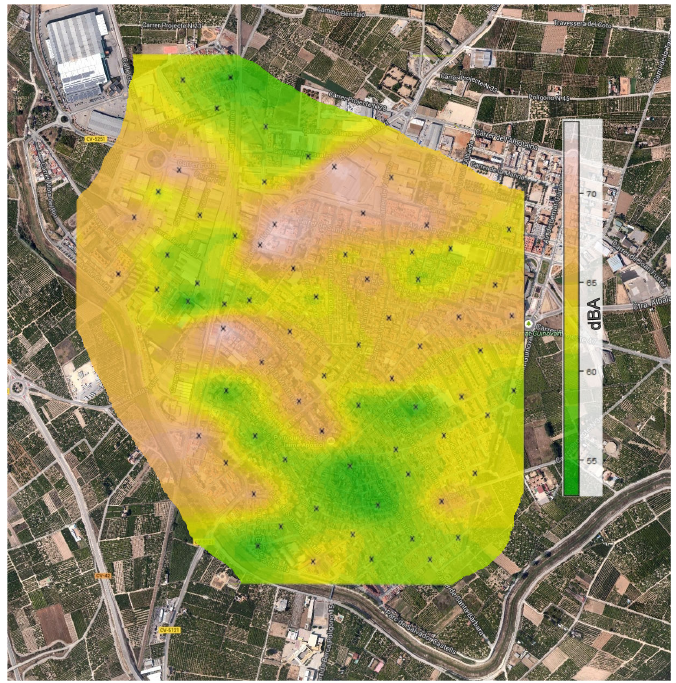
Figure 9. Interpolated time-average noise levels on a map